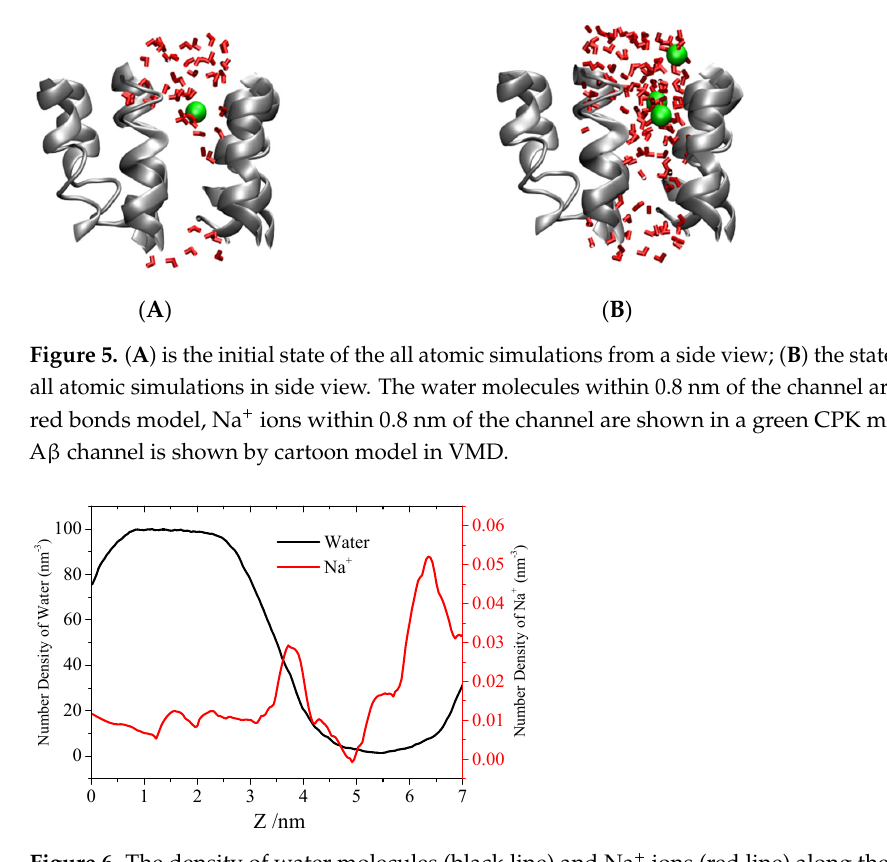
Figure 6. The density of water molecules (black line) and Na + ions (red line) along the z axis of the DPPC